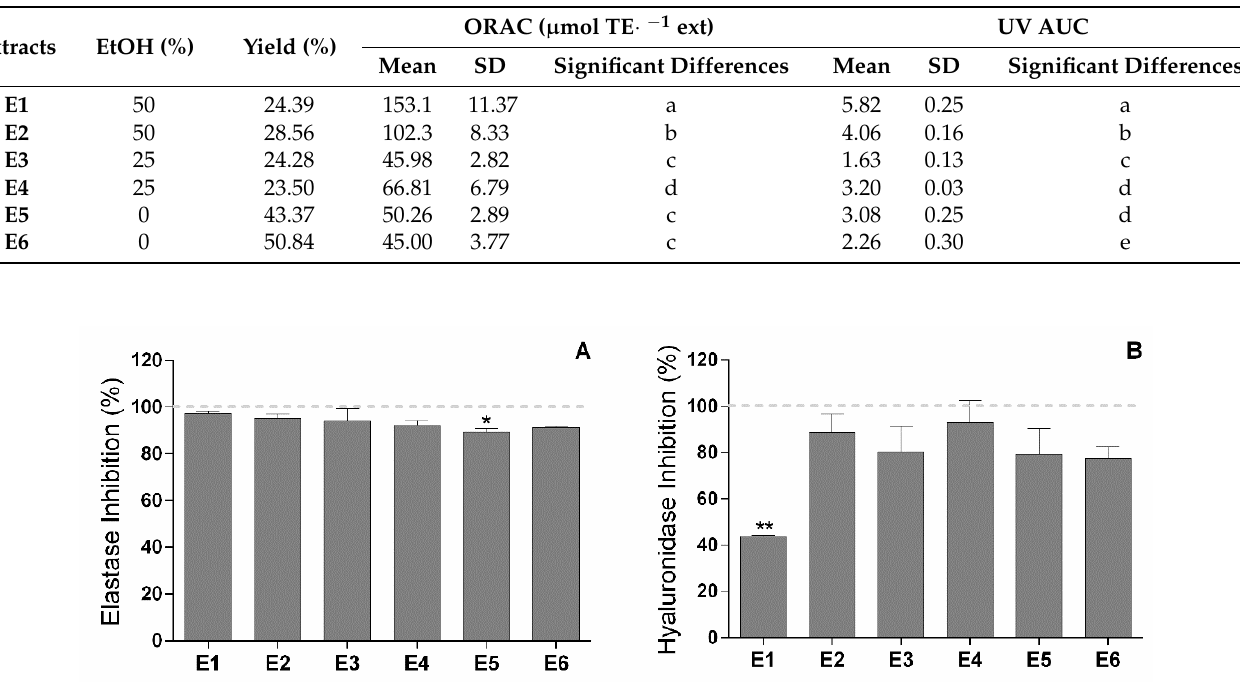
Table 2. Selected extracts of Grateloupia turuturu and respective ethanol percentage, yield, antioxidant capacity by ORAC assay (expressed as µ mol of Trolox equivalents (TE) per gram of extract) and UV absorbance, using the area under the curve. Holm–Sidak’s multiple comparisons test was performed to understand the significant differences between extracts (different letters represent statistically significant differences, with p < 0.05).